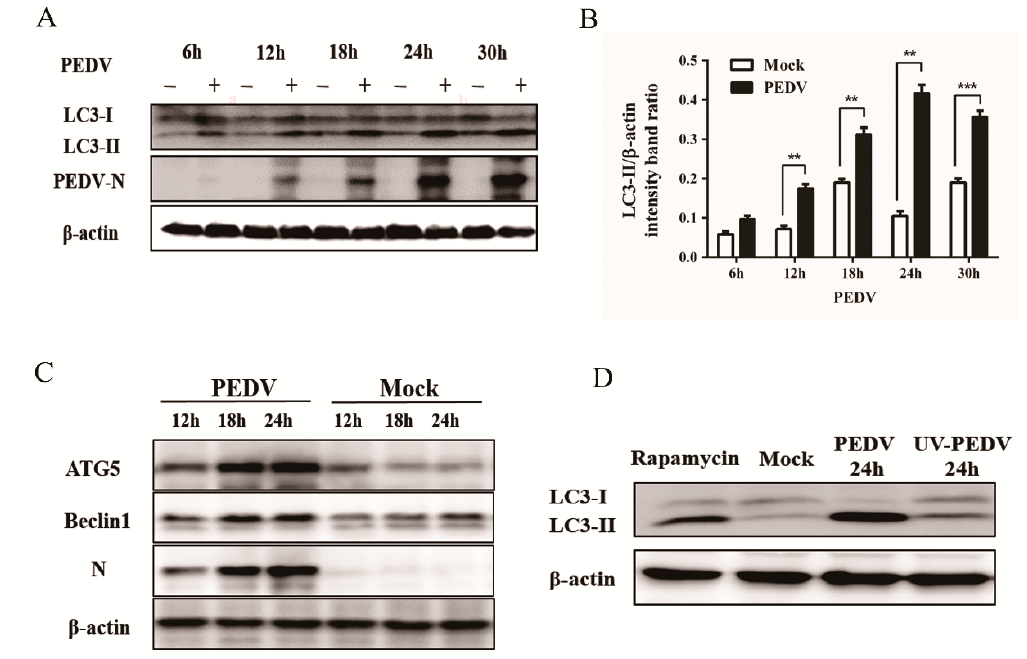
Figure 2. Expression of autophagy marker proteins in PEDV infected Vero cells. ( A ) Western blot analysis of the turnover of LC3-I to LC3-II in Vero cells at the indicated time points post PEDV infection using a polyclonal antibody against LC3 or a monoclonal antibody against PEDV N. β -actin expression was used as a protein loading control. ( B ) The intensity band ratio of LC3-II to β -actin was analyzed by using ImageJ software. The data were presented as mean ± SEM of three independent experiments ( t- test, * p < 0.05, ** p < 0.01, *** p < 0.001). ( C ) Western blot analysis of the level of ATG5 and Beclin1 in Vero cells at 12, 18, and 24 hpi. β -actin expression was used as a protein loading control. ( D ) The turnovers of LC3-I to LC3-II were detected for mock-treated, rapamycin-treated, native